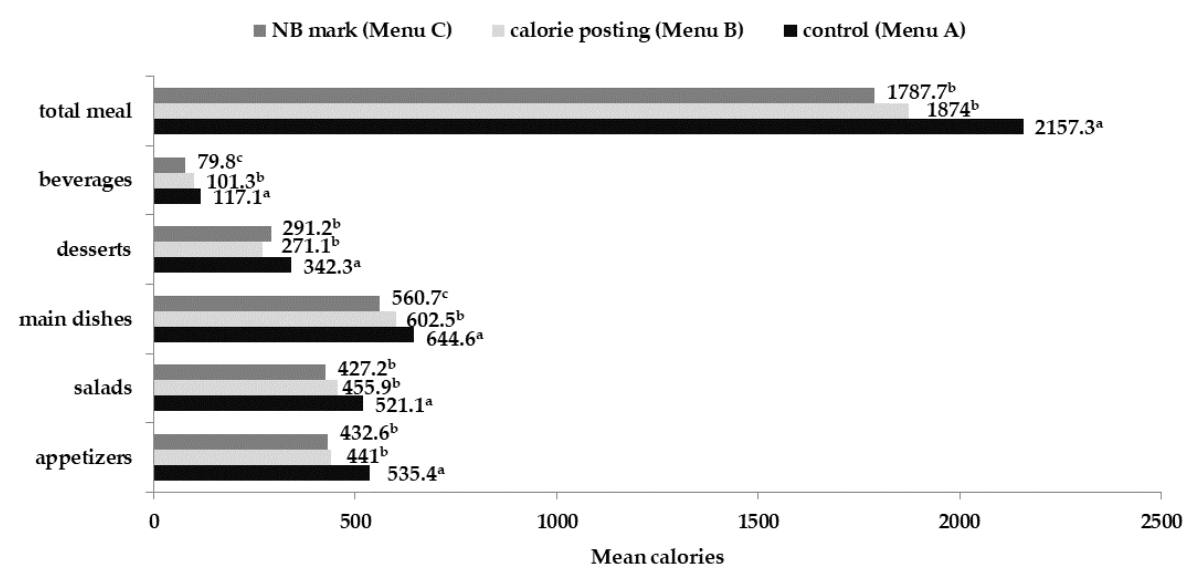
Figure 1. Mean selected calories for each menu category for the three different menus. The superscript letters (a,b,c) display the statistically significant differences ( p < 0.05) between the selected calories per menu category (appetizer, salads etc.).